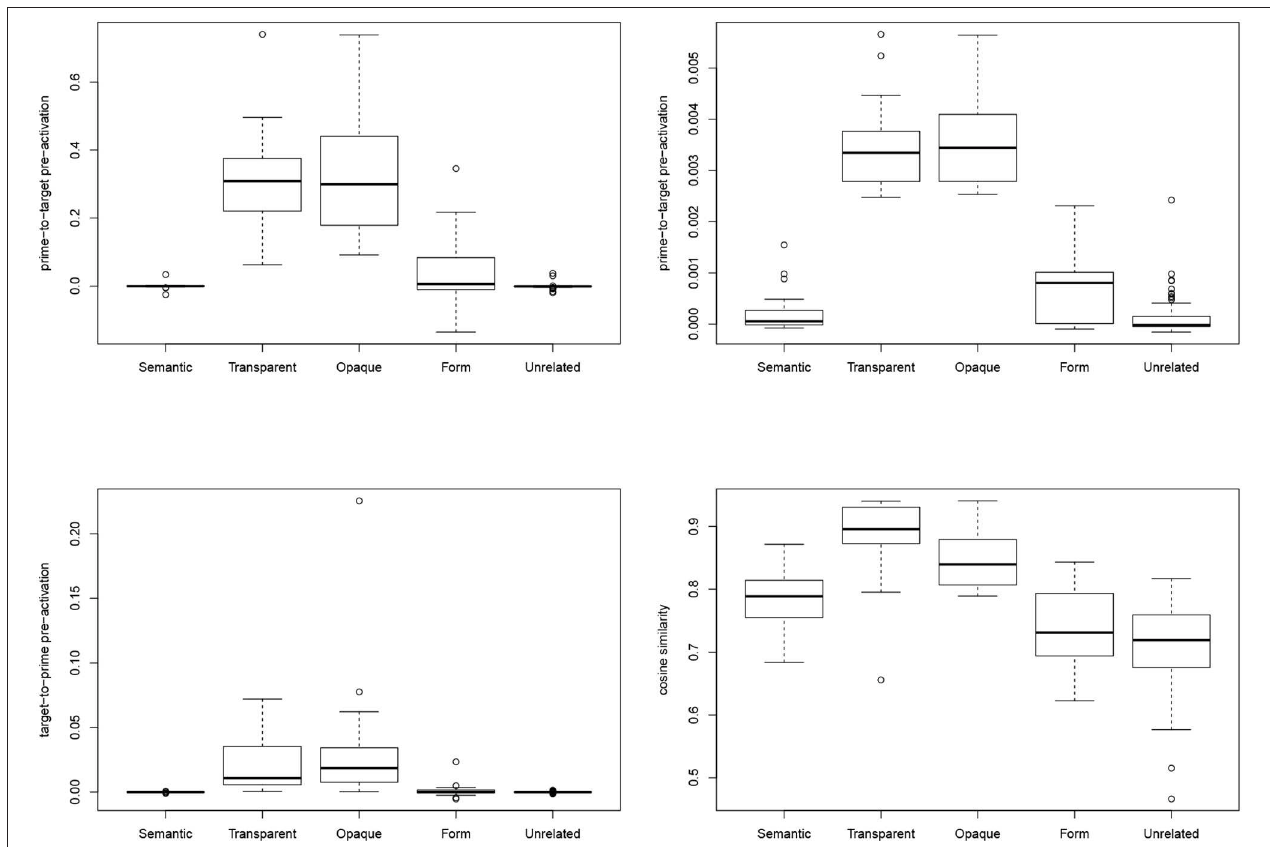
FIGURE 4 | Predicted NDL Prime-to-Target Pre-Activation using empirical word frequencies (upper left panel), Predicted NDL Prime-to-Target Pre-Activation using uniformly distributed frequencies (upper right panel), Target-to-Prime Pre-Activation using empirical frequencies (lower left panel), and Prime-target Cosine Similarity (lower right panel), broken down by prime